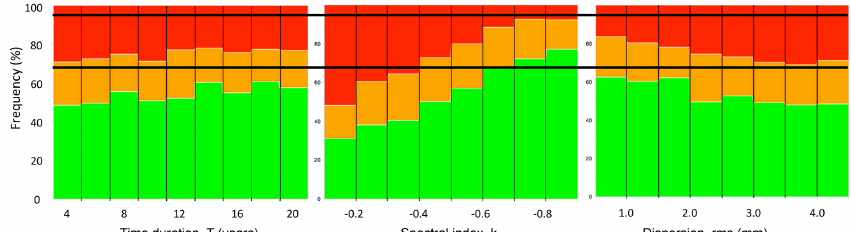
Figure 8. Distribution of the ratio of the velocity bias to its standard error for each individual time series. A ratio of 1 corresponds to a standard error equal to its velocity. A ratio smaller (greater) than 1 corresponds to a standard error greater (smaller) than its velocity. Ratio: less than 1 in green, less than 2 in orange, and greater than 2 in red. The black lines correspond to the 68% and 95% marks for normal distributions of the velocities and standard errors.